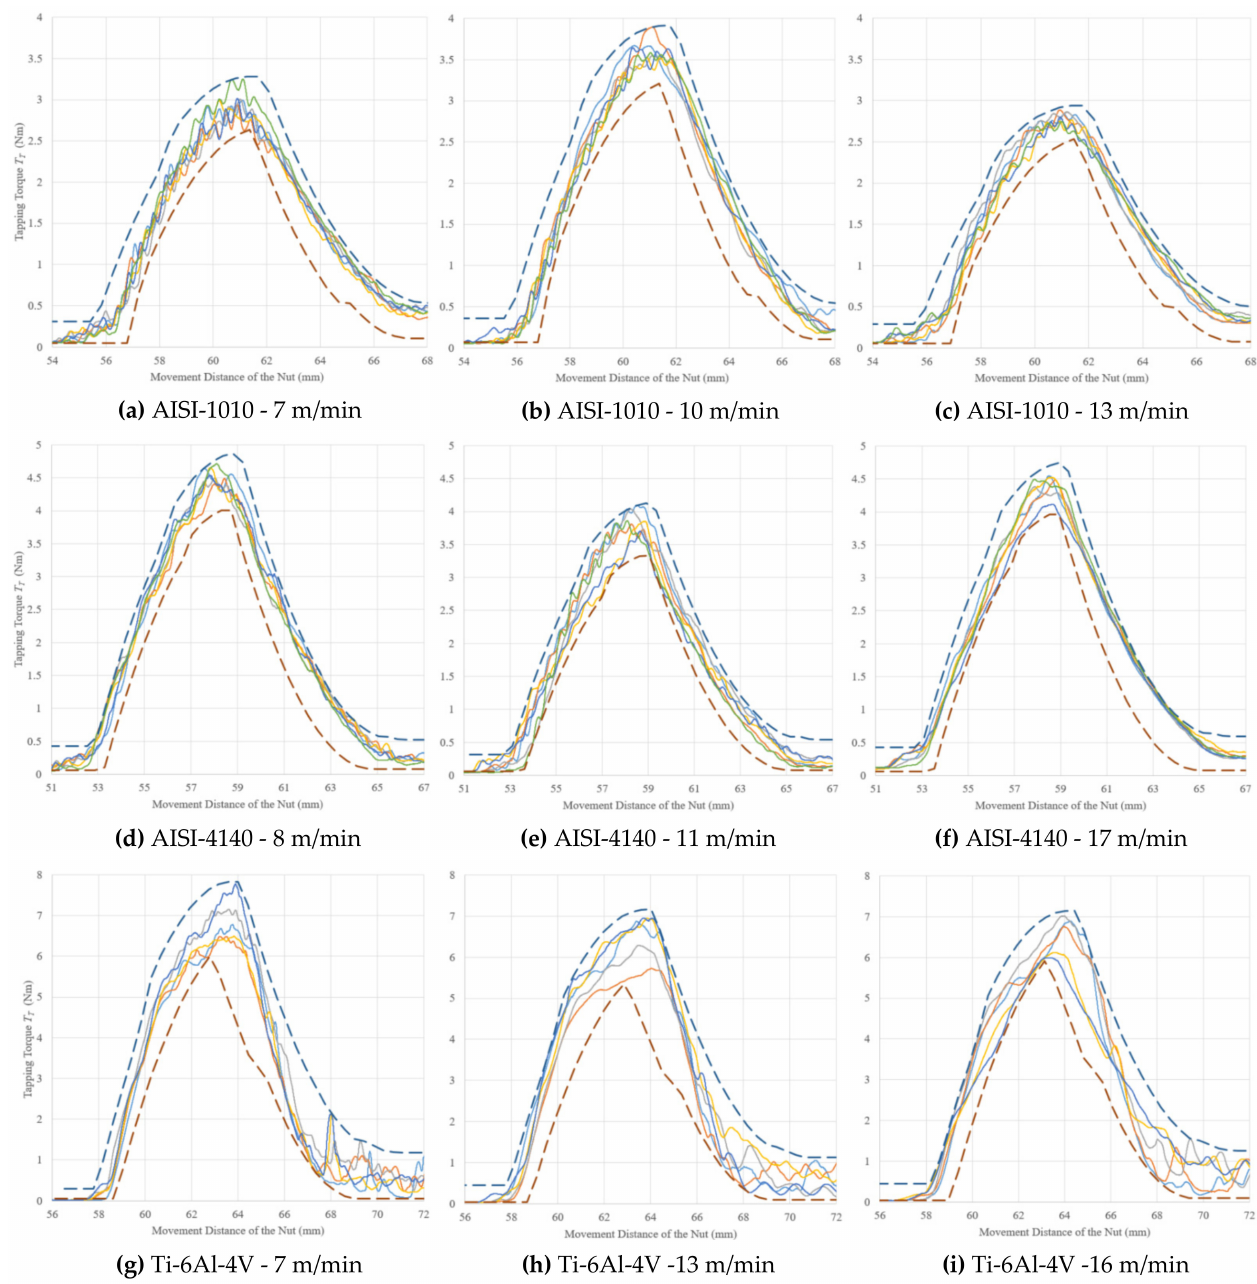
Figure 12. AISI-1010, AISI-4140, and Ti-6Al-4V in different cutting speeds with quality assurance